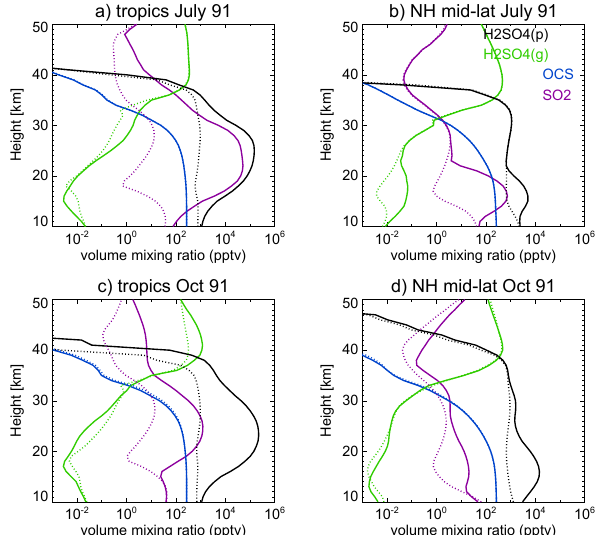
Figure 3. Volume mixing ratios of various sulfur containing species (pptv) in the tropics (20 ◦ S–20 ◦ N, left) and NH mid-latitudes (35– 60 ◦ N, right) during July 1991 (top) and October 1991 (bottom). Gas phase and particle phase H 2 SO 4 ratios are shown with green and black lines, respectively. OCS and SO 2 are shown with blue and purple lines, respectively. Runs A_Control20 and C_noPinatubo are shown with solid and dashed lines,